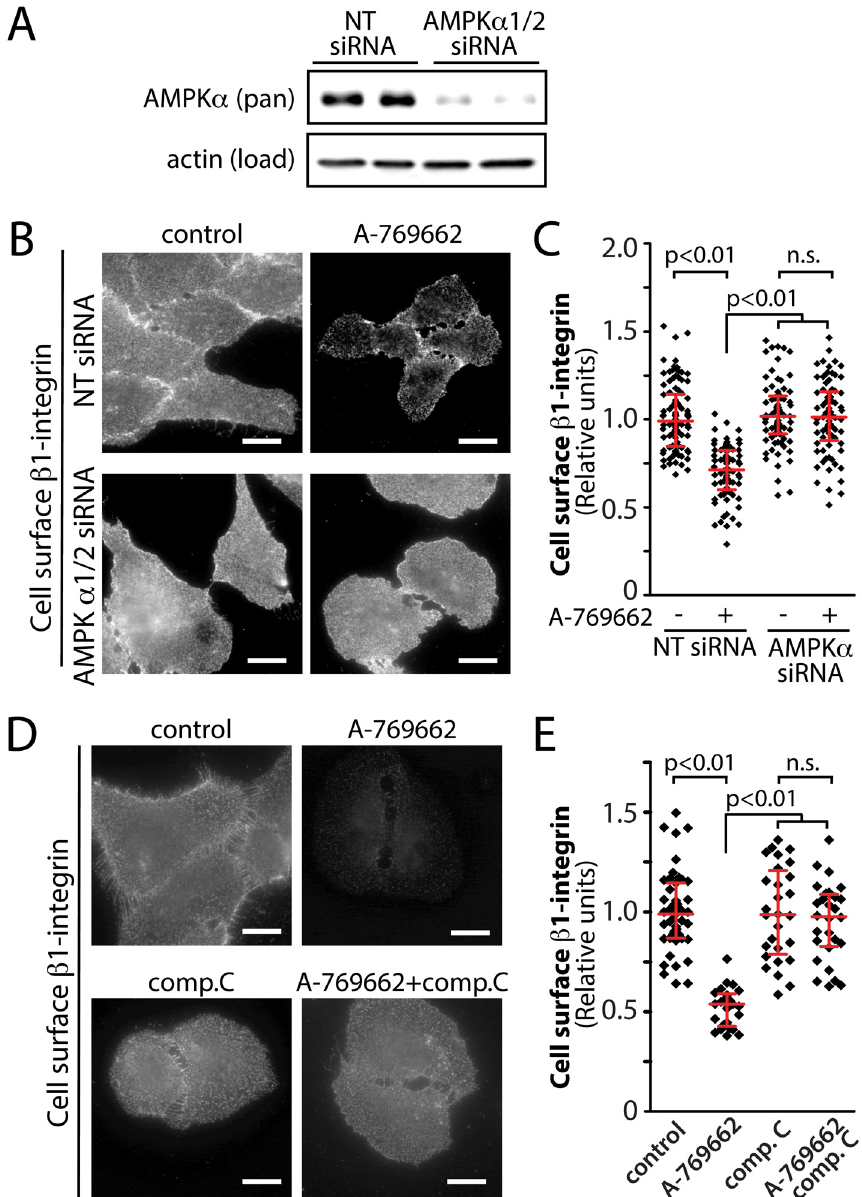
Fig 5. Inhibition of AMPK by siRNA gene silencing or by compound C prevents the reduction in cell surface β 1-integrin elicited by A-769662 treatment. ( A-C) RPE cells were transfected with siRNA targeting AMPK α 1/2 or non-targeting (NT, control) siRNA. ( A ) Whole cell lysates were prepared and resolved by immunoblotting and probed with anti-AMPK α 1/2 or anti-actin antibodies. Shown are immunoblots representative of at least 3 independent experiments. ( B ) Following siRNA transfection, cells were treated with 100 μ M A-769662 for 60 min as indicated. Intact cells were labeled with an antibody specific for an exofacial epitope on β 1-integrin. Shown are representative fluorescence micrographs depicting cell surface β 1-integrin fluorescence. Scale = 5 μ m ( C) Cell surface β 1-integrin levels obtained by fluorescence microscopy were quantified. Shown are the cell surface β 1-integrin measurements in individual cells (diamonds) as well as the median ± interquartile range of these values in each treatment condition (n = 3 independent experiments). ( D ) RPE cells were treated with 100 μ M A-769662 or 40 μ M compound C, alone or in combination, for 60 min as indicated. Intact cells were labeled with an antibody specific for an exofacial epitope on β 1-integrin. Shown are representative fluorescence micrographs depicting cell surface β 1-integrin fluorescence. Scale = 5 μ m ( E) Cell surface β 1-integrin levels obtained by fluorescence microscopy as in (D) were quantified. Shown are the cell surface β 1-integrin measurements in individual cells (diamonds) as well